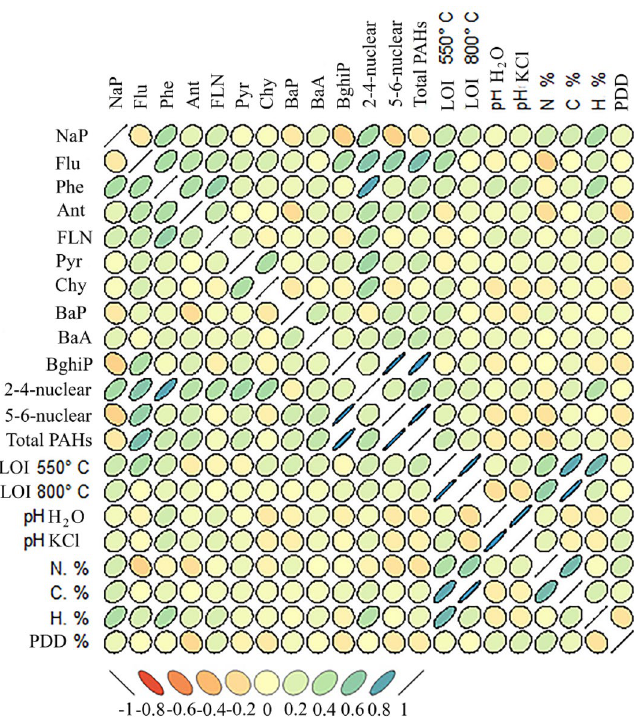
Figure 4. Coefficients of Pearson correlation between the PAH content and main indicators of the physicochemical properties of peat. PDD—peat decomposition degree,